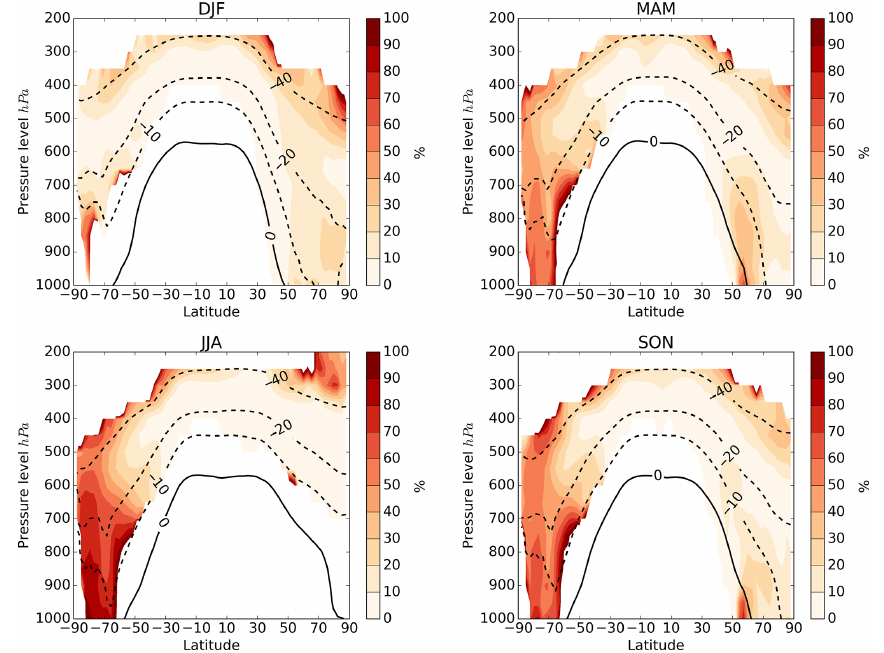
Figure 7. Percentage of days when [INP] ambient from marine organic aerosols is greater than from K-feldspar. The number of days have been calculated only for times and locations where the total [INP] ambient concentration is larger than 0.1m − 3 . The black contour lines represent seasonal mean isotherms in degrees